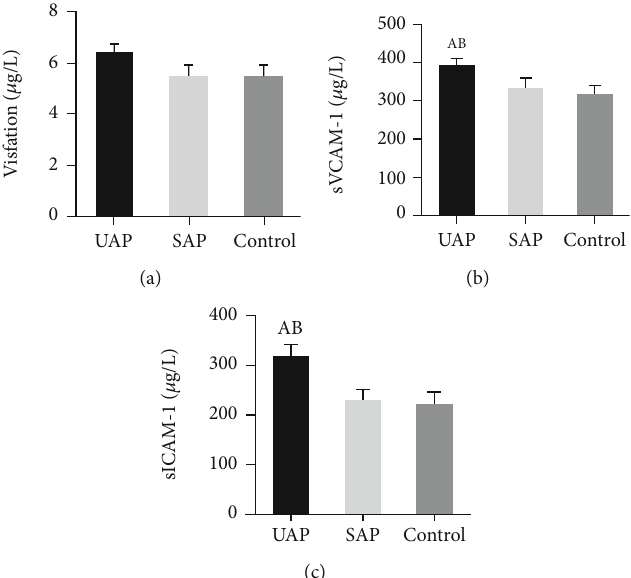
Figure 2: Comparison on Visfatin, sVCAM-1, and sICAM-1 levels. (a – c) The comparisons on Visfatin, sVCAM-1, and sICAM-1 levels, respectively. A and B suggested the di ff erence was obvious to the control group and SAP group, respectively ( P < 0 : 05 ).